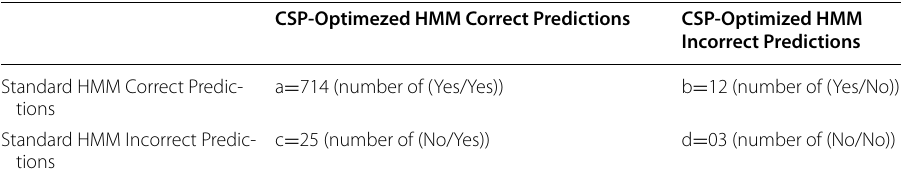
Incorrect Predictions